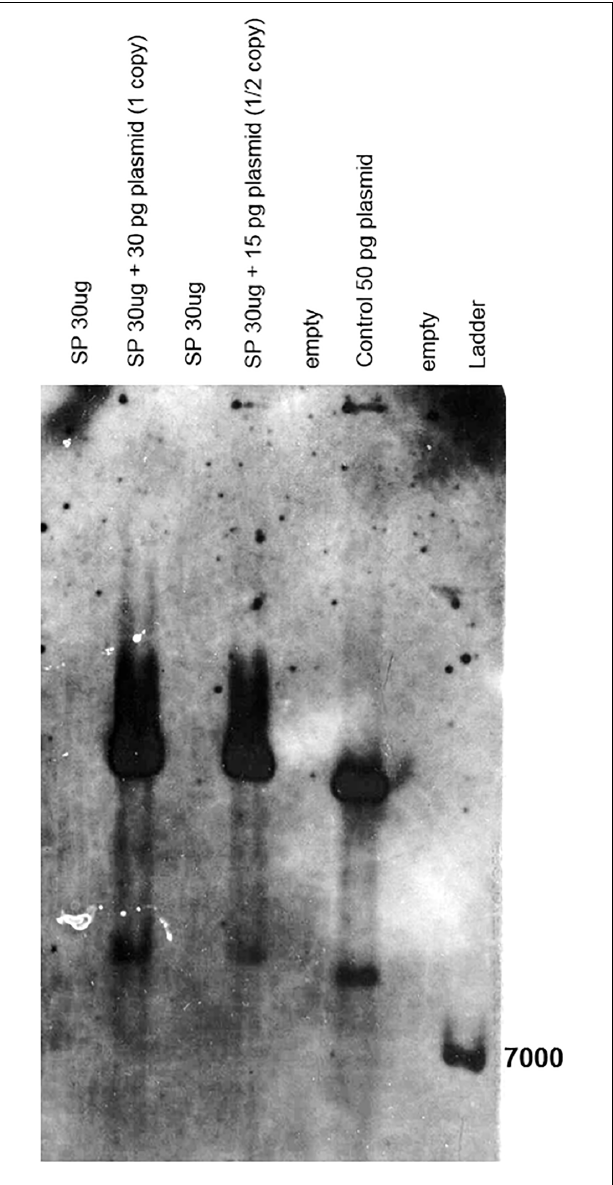
FIGURE 3 | Southern blot of “Huachano” DNA linearized with Pst I and hybridized with a probe corresponding to SPPV-B. From left to right, the first and third lanes contain 30 µ g of sweet potato (SP) DNA, and the second and fourth lanes contain 30 µ g of SP DNA spiked with 30 and 15 pg of plasmid (containing SPPV-B DNA fragment corresponding to the probe), respectively, corresponding to 1 or one-half a copy per sweet potato genome equivalent; the fifth and seventh lanes are empty, whereas the sixth lane contains 50 pg of SPPV-B plasmid DNA, and the last lane, a DNA